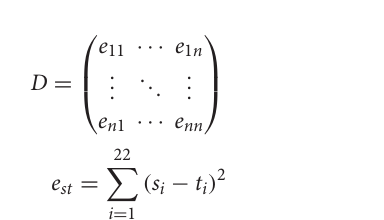
coordinate system.